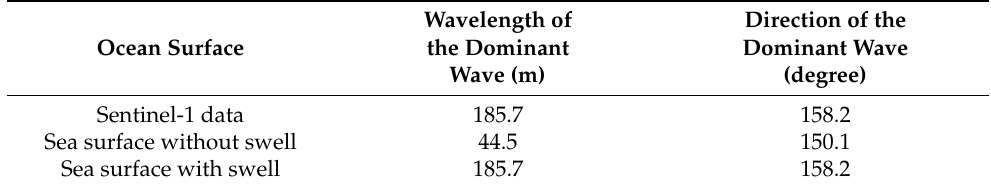
Figure 21. Similar to Figure 17 but corresponding to ID 3.